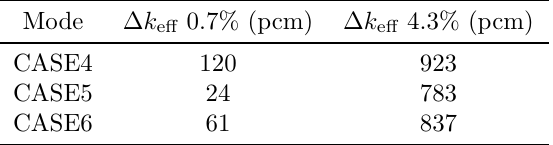
Table 5. k eff relative difference between SCALE and PARCS with 56 groups calculation